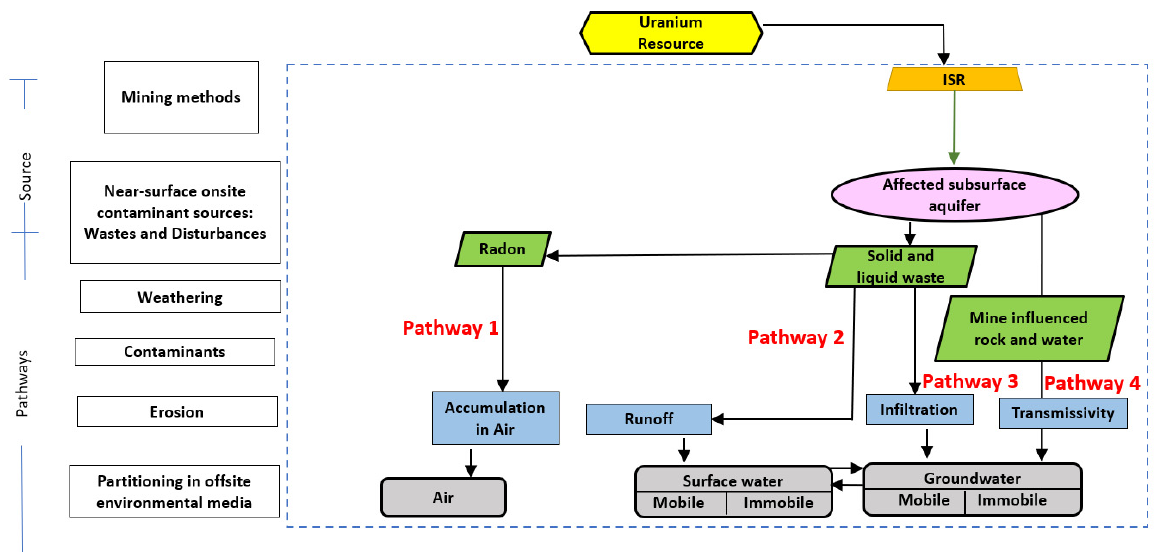
Figure 8. Conceptual source-to-receptor model for in situ uranium recovery (ISR) of undiscovered uranium resources in the Texas Coastal Plain. Modified from [12].